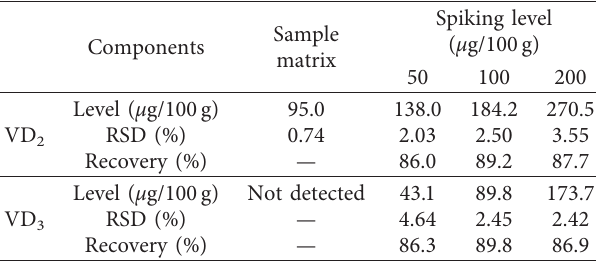
Table 3: Recovery of Lentinula edodes powder with different spiking levels ( n � 6).